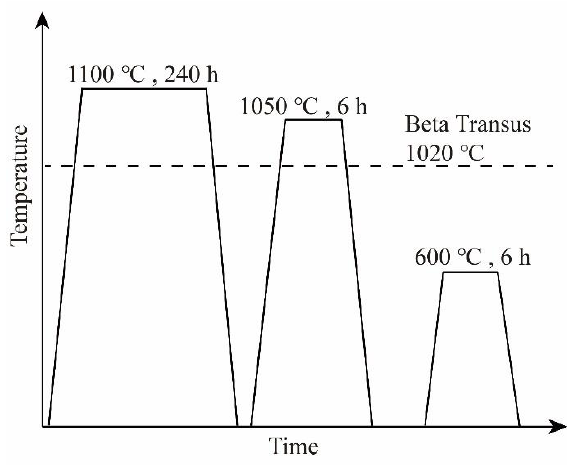
Figure 2. Heat treatment schedule for the Ti6Al4V-Ti6Al4V20Fe-Ti6Al4V20Cr-Ti6Al4V20Mo-Ti6Al4V45Zr diffusion multiple (this figure is not to scale.).